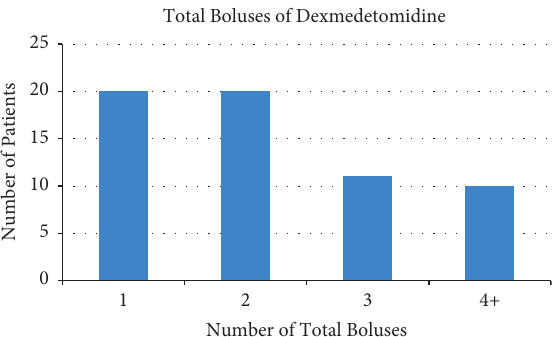
Figure 2: Number of dexmedetomidine boluses administered. Bar graph of the number of patients who received a given number of dexmedetomidine boluses. Table 2: Incidence of general anesthesia conversion, hypotension, bradycardia, and O adjuncts or nitrous